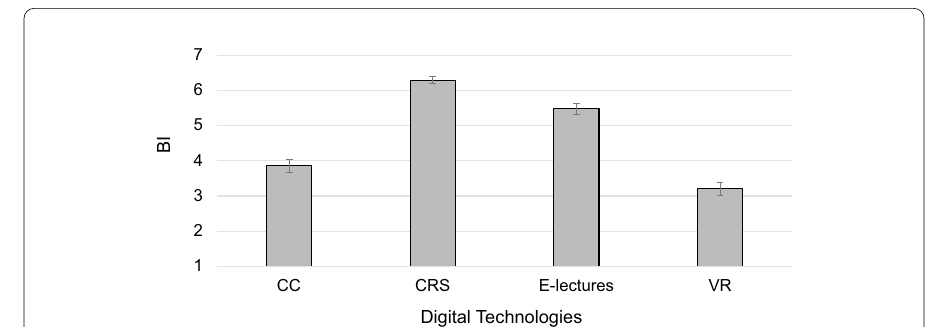
Fig. 7 Behavioral intention for the CC, CRS, e-lectures and after three months of usage. The error bars represent the standard errors of the mean